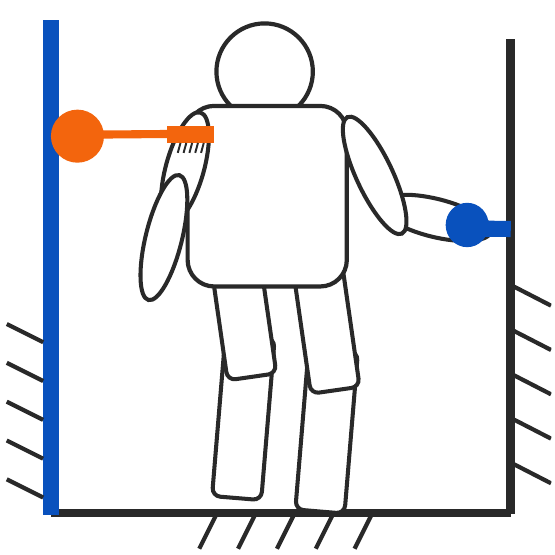
Figure 9. Example of a support tool on